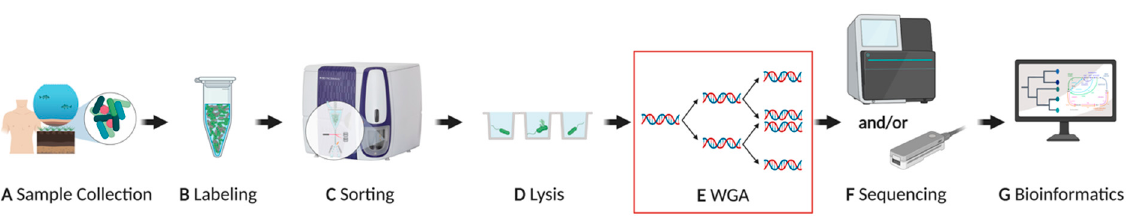
Figure 1. General overview of a single ‐ cell genomics pipeline. ( A ) Environmental samples should Figure 1. General overview of a single-cell genomics pipeline. ( A ) Environmental samples should be immediately processed, or deep ‐ frozen in the presence of a cryoprotectant that preserves the be immediately processed, or deep-frozen in the presence of a cryoprotectant that preserves the integrity of the cell. ( B ) Cells are typically stained with a non ‐ specific fluorescent dye, such as DAPI integrity of the cell. ( B ) Cells are typically stained with a non-specific fluorescent dye, such as or SYBR ® Green, but they can also be specifically labeled, e.g., with fluorescence in situ hybridiza ‐ DAPI or SYBR ® Green, but they can also be specifically labeled, e.g., with fluorescence in situ tion. ( C ) Fluorescence activated cell sorting (FACS) is the most common choice for physical isolation hybridization. ( C ) Fluorescence activated cell sorting (FACS) is the most common choice for physical of a single cell into multi ‐ well plates ( D ). Once isolated, the single cells are lysed, typically with a isolation of a single cell into multi-well plates ( D ). Once isolated, the single cells are lysed, typically combination of alkaline buffer and freeze ‐ thaw cycling, to release the DNA from the cell. ( E ) Whole with a combination of alkaline buffer and freeze-thaw cycling, to release the DNA from the cell. genome amplification (WGA) is required to generate sufficient amounts of DNA for library prepa ‐ ( E ) Whole genome amplification (WGA) is required to generate sufficient amounts of DNA for library ration since a typical prokaryotic cell only contains a few femtograms of DNA. ( F ) Once DNA li ‐ preparation since a typical prokaryotic cell only contains a few femtograms of DNA. ( F ) Once DNA braries are prepared, short ‐ and/or long ‐ read sequencing platforms such as Illumina ® and Oxford Nanopore Technologies ® , respectively, can be employed. ( G ) Finally, bioinformatics is utilized to libraries are prepared, short- and/or long-read sequencing platforms such as Illumina ® and Oxford conduct the quality assessment, assembly, classification, ORF calling, and annotation of the se ‐ Nanopore Technologies ® , respectively, can be employed. ( G ) Finally, bioinformatics is utilized to quences. Created with BioRender.com. Modified from Kaster & Sobol (2020) [17]. conduct the quality assessment, assembly, classification, ORF calling, and annotation of the sequences. Created with BioRender.com. Modified from Kaster & Sobol (2020)